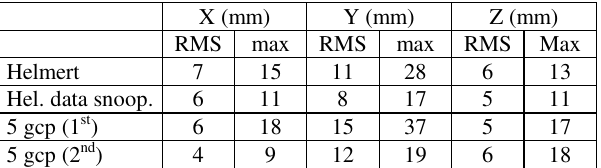
Table 3. Myson, automatic orientation: statistics of the discrepancies with the two methods.